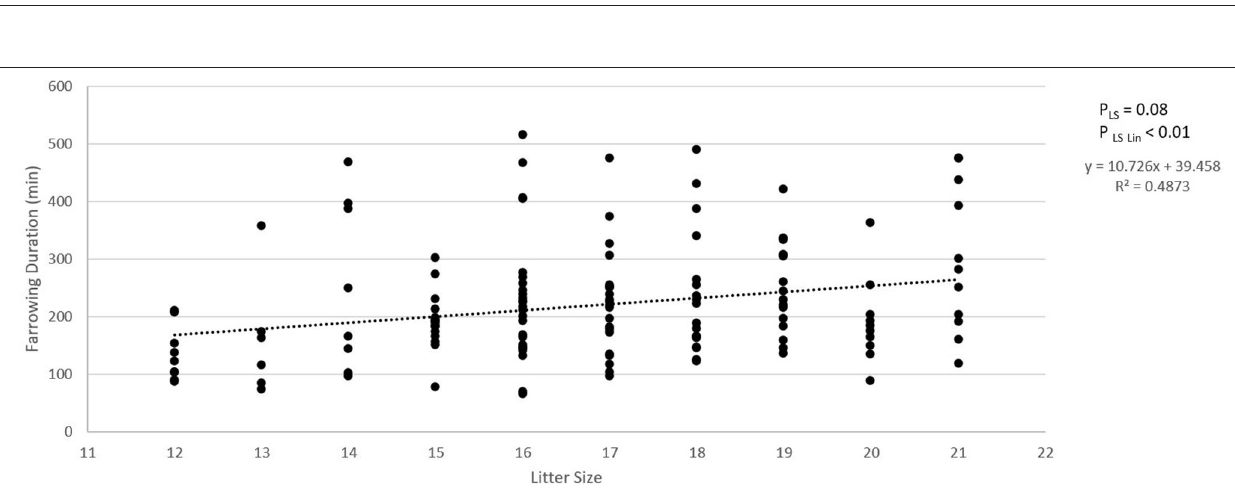
Frontiers in Veterinary Science |